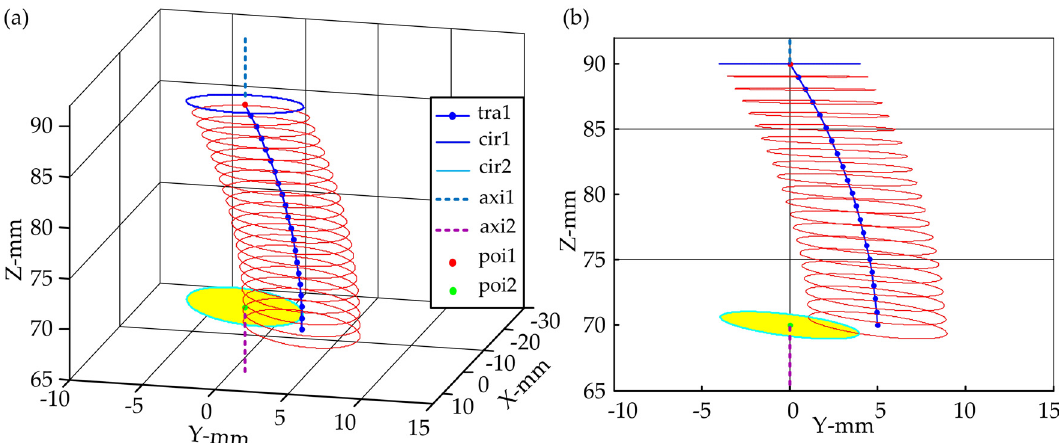
Figure 7. ( a ) The shape and trajectory of the bone with equal joint adjustment. ( b ) The view in the Y–Z plane. The trajectory of tra1 represents the bone trajectory. The circles cir1 and cir2 denote the growth interface in the last step and the proximal bone end plane, respectively. The axes of axi1 and axi2 represent the axes of the distal and proximal bone segments, respectively.